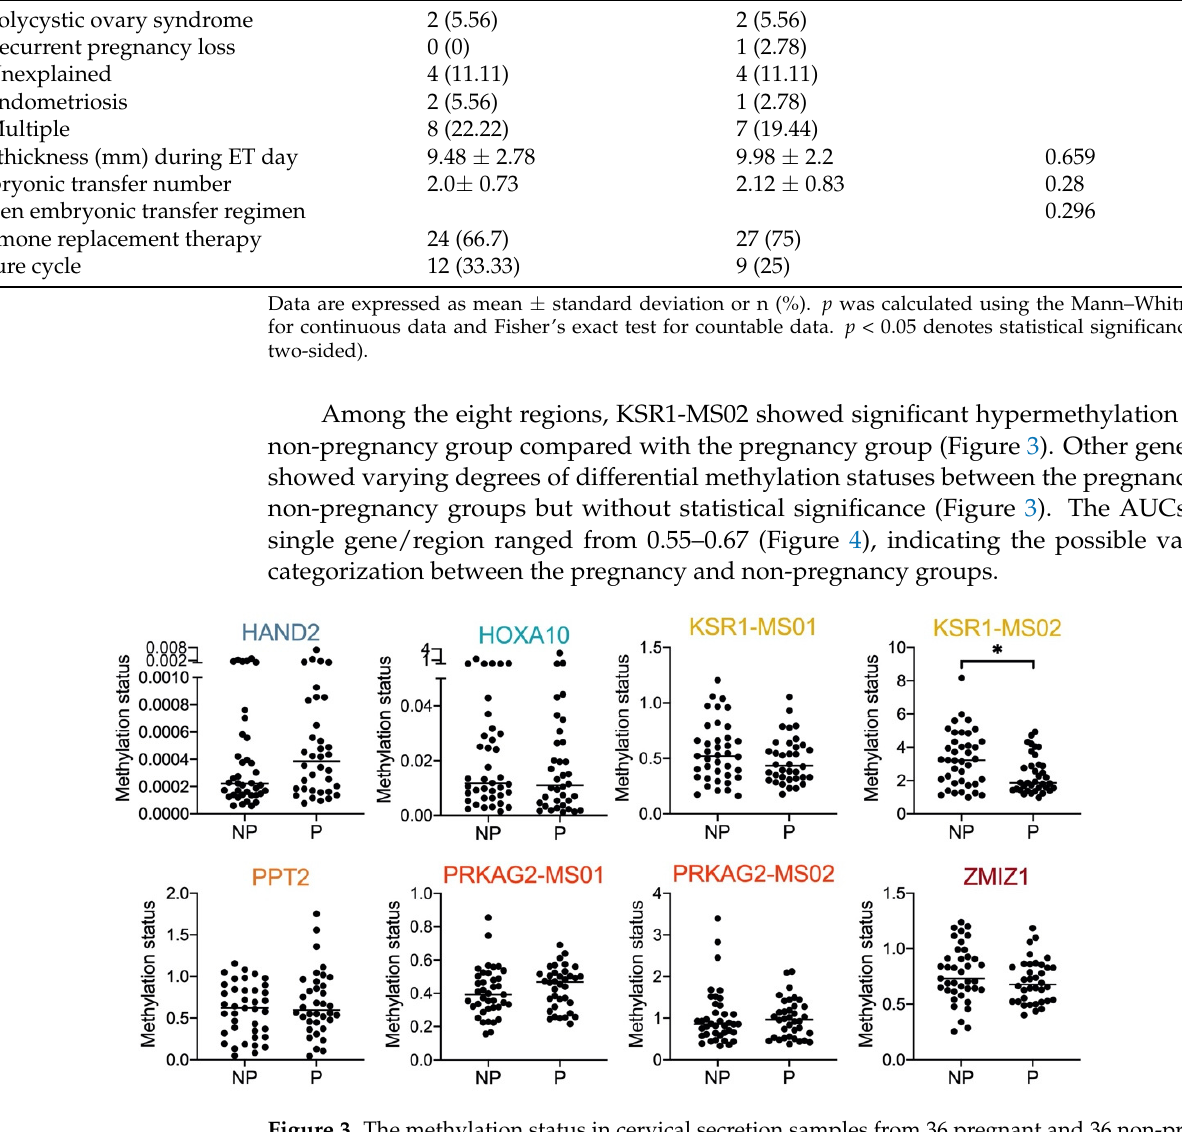
Figure 4. The AUC of single candidate gene/CpG site with respect to pregnancy prediction.